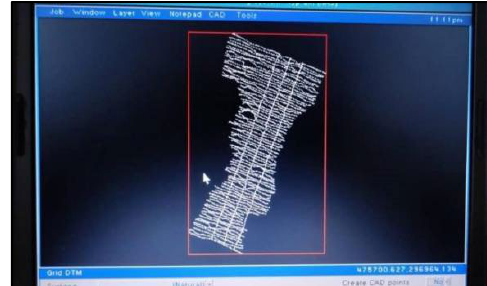
Figure 3. The interface of DOS Processing while editing